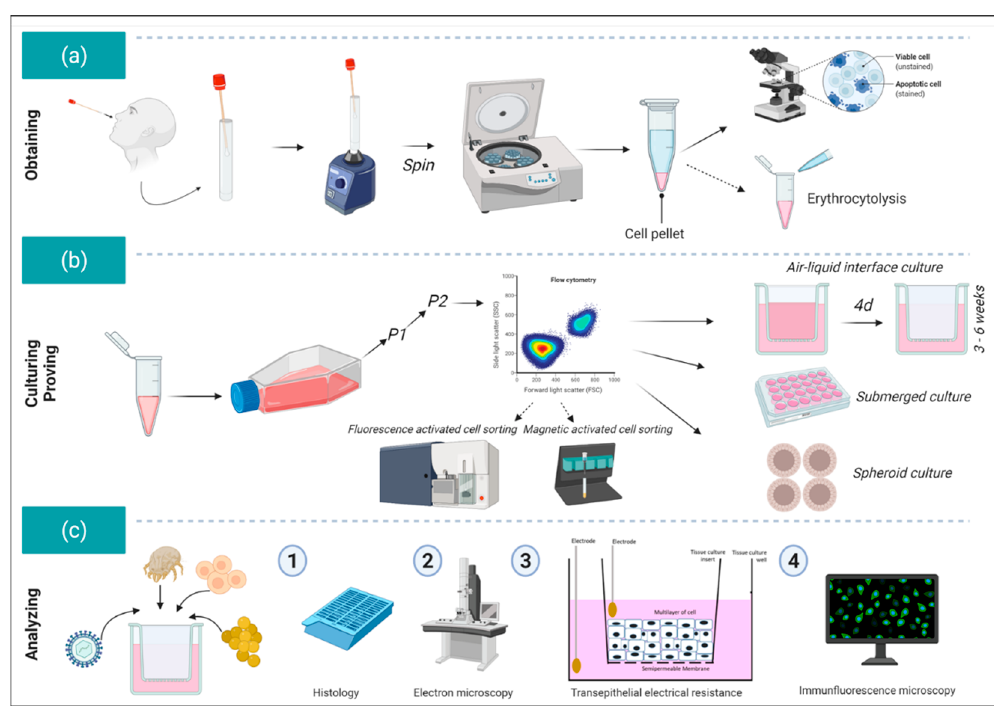
Figure 2. An overview of the workflow for analyzing primary human nasal epithelial cells. ( a ) After careful collection of the nasal epithelial cells from the nasal cavity using a cytology or interdental brush, cells are transferred to a 15 mL tube and shaken several times. The brush is then removed, and the cells are centrifuged. The cells are checked for viability using a Neubauer counting chamber using trypan blue or Türk’s solution (purchased from Sigma Aldrich). If necessary, erythrocytolysis can be also performed separately. ( b ) The cells are then seeded into collagen-coated T25/T75 flasks in, for example, BEGM TM medium. After two passages, flow cytometric characterization of the cells can be performed if needed. If the cultures lack purity, separation by Magnetic-activated cell sorting (MACS) or Fluorescence-activated cell sorting (FACS) can be also performed (usually these steps are not necessary). Afterwards the nasal epithelial cells are either transferred into air–liquid interface cultures (ALI) (approximately 9–11 × 10 4 cells per 1.12 cm 2 or 2–3 × 10 4 cells per 0.33 cm 2 cell culture inserts = transwells), or directly seeded in submerged cultures. For certain questions, nasal epithelial cells can be also seeded for spheroid cultures (circa 1000 cells per U-bottom well). ( c ) Different provocation experiments or co-cultures can be performed with the cultures (here schematic presentation for ALI cultures) and subsequently, the morphology of the cells can be studied through histology and electron microscopy [22]. By means of transepithelial electrical resistance measurement, the integrity of the cell–cell interaction can be measured, or the permissiveness can be investigated through immunofluorescence microscopic analysis. This content of this figure correlates thematically with [22] and was not previously published elsewhere. This figure was created with www.biorender.com (accessed on 27 February